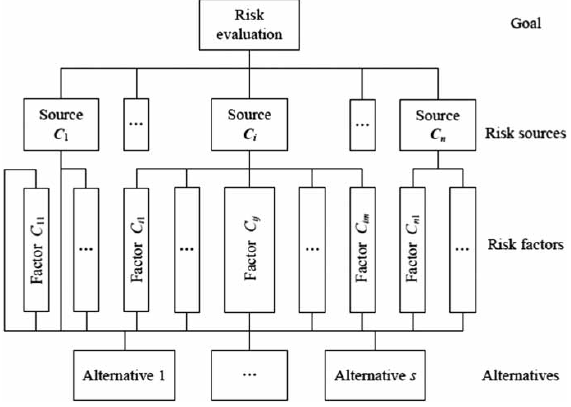
Fig. 1. Theoretical model of risk evaluation (Sun et al. 2008)